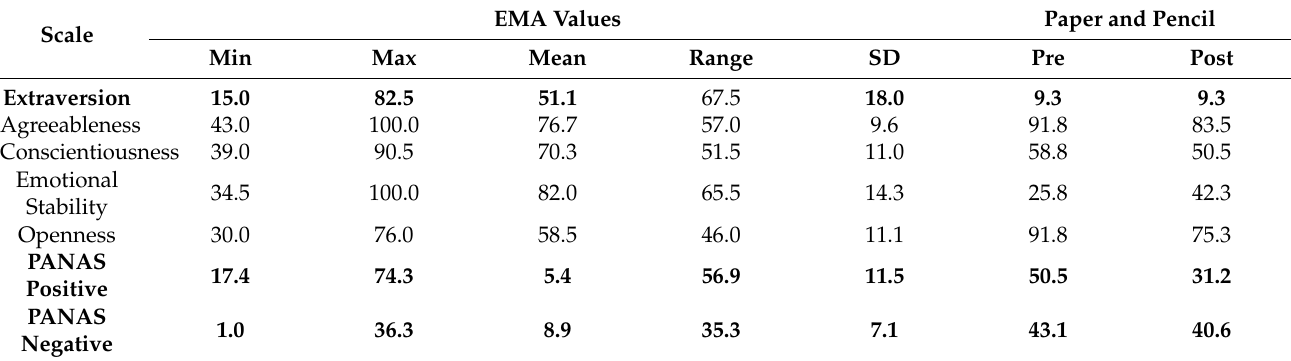
Table 1. Personality and affect variability: Bob ( n = 74–76 observations).